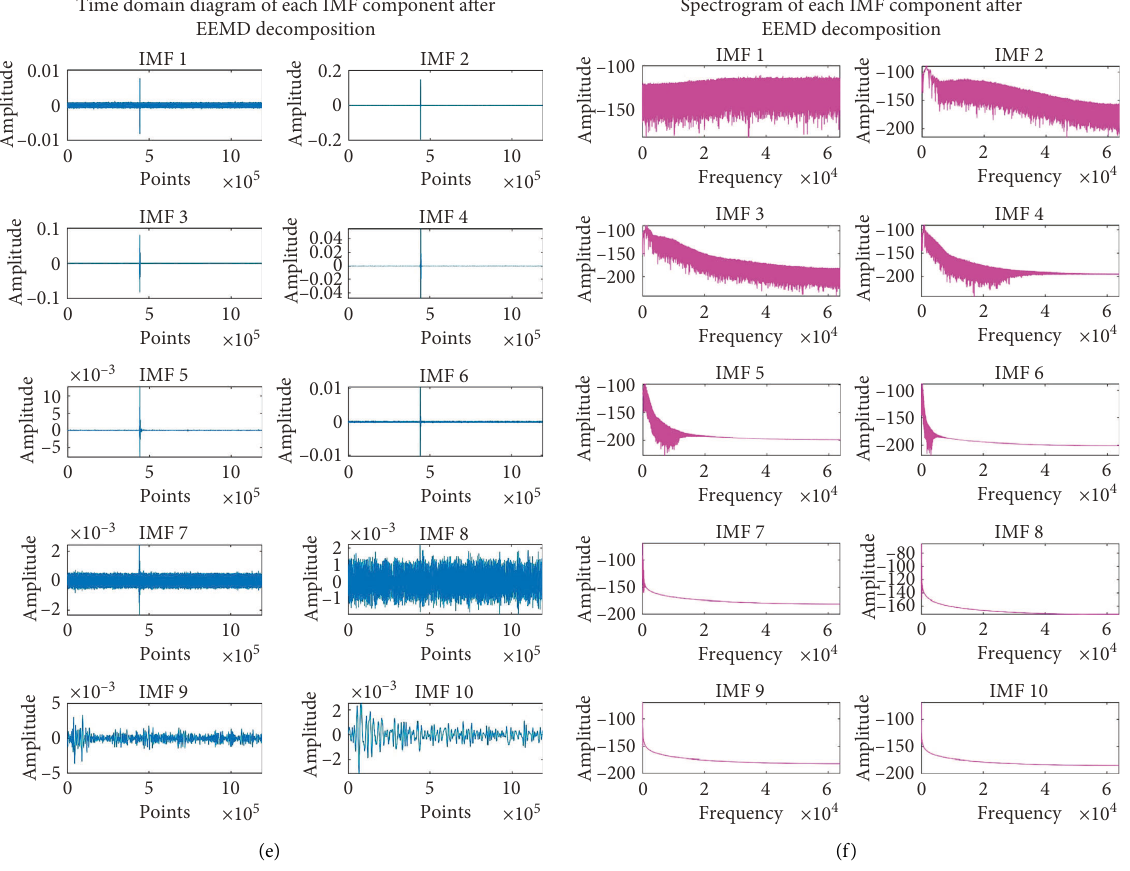
Figure 22: Three-way signal EEMD decomposition. (a) Time domain diagram of the IMF component of the EMD decomposition of the first signal. (b) Spectrogram of the IMF component decomposed by EMD of the first signal. (c) Time domain diagram of the IMF component of the EMD decomposition of the second signal. (d) Spectrogram of the IMF component decomposed by EMD of the second signal. (e) Time domain diagram of the IMF component of the EMD decomposition of the third signal. (f) Spectrogram of the IMF component decomposed by EMD of the third